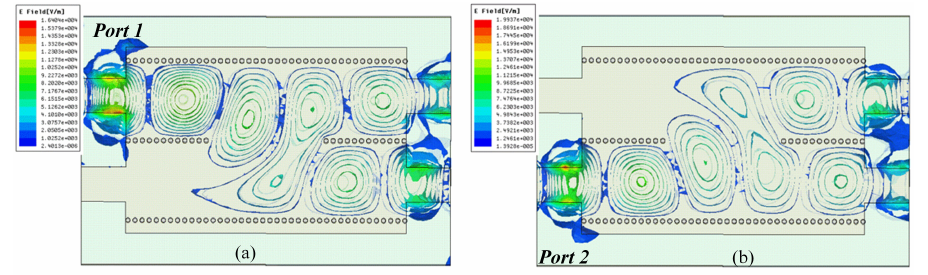
Figure 6. The electric field distribution of the coupler under different port excitations ( a , b